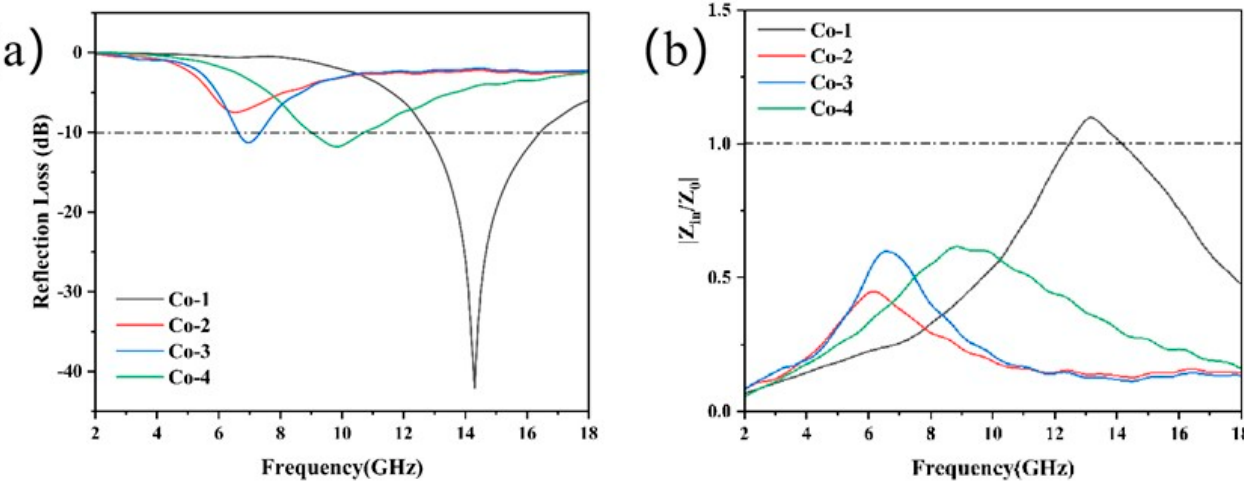
Figure 8. Reflection loss diagram ( a ) and impedance matching ( b ) of CoFe 2 O 4 /SWCNTs heterostruc- tures with different cobalt salt additions at a thickness of 1.5 mm. tures with different cobalt salt additions at a thickness of 1.5